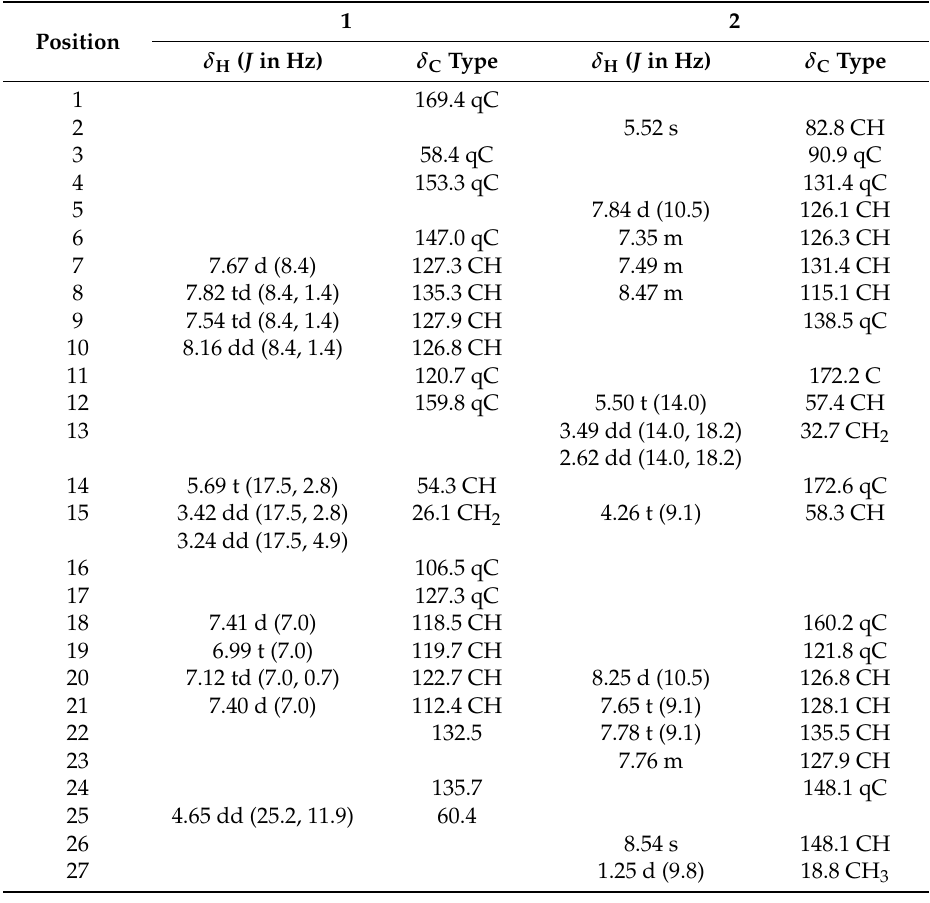
Table 1. 1 H (700 MHz) and 13 C (175 MHz) NMR and HMBC data for 1 (DMSO- d 6 ) and 2 (DMSO- d 6 ).